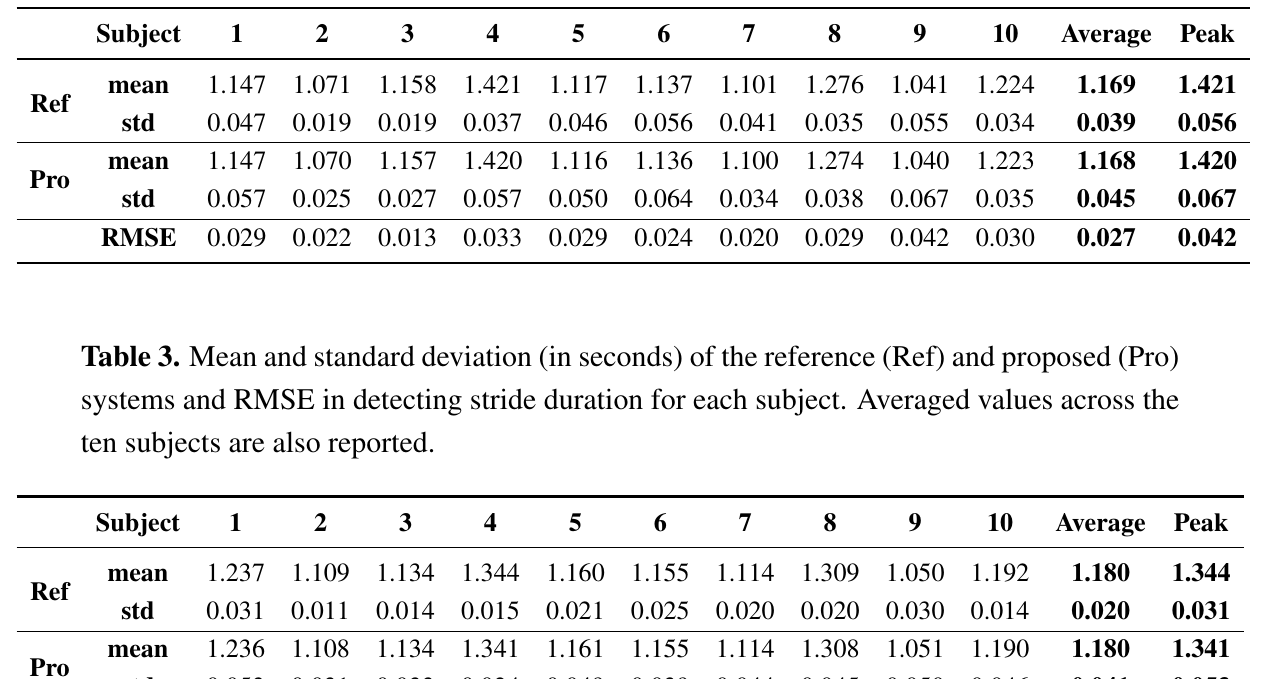
Table 2. Mean and standard deviation (in meters) of the reference (Ref) and proposed (Pro) systems and RMSE in detecting stride length for each subject. Averaged values across the ten subjects are also reported.